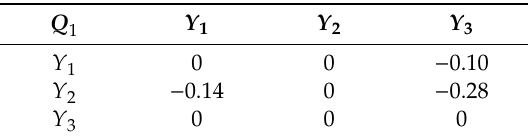
Table 4. The regret matrix Q 1 .